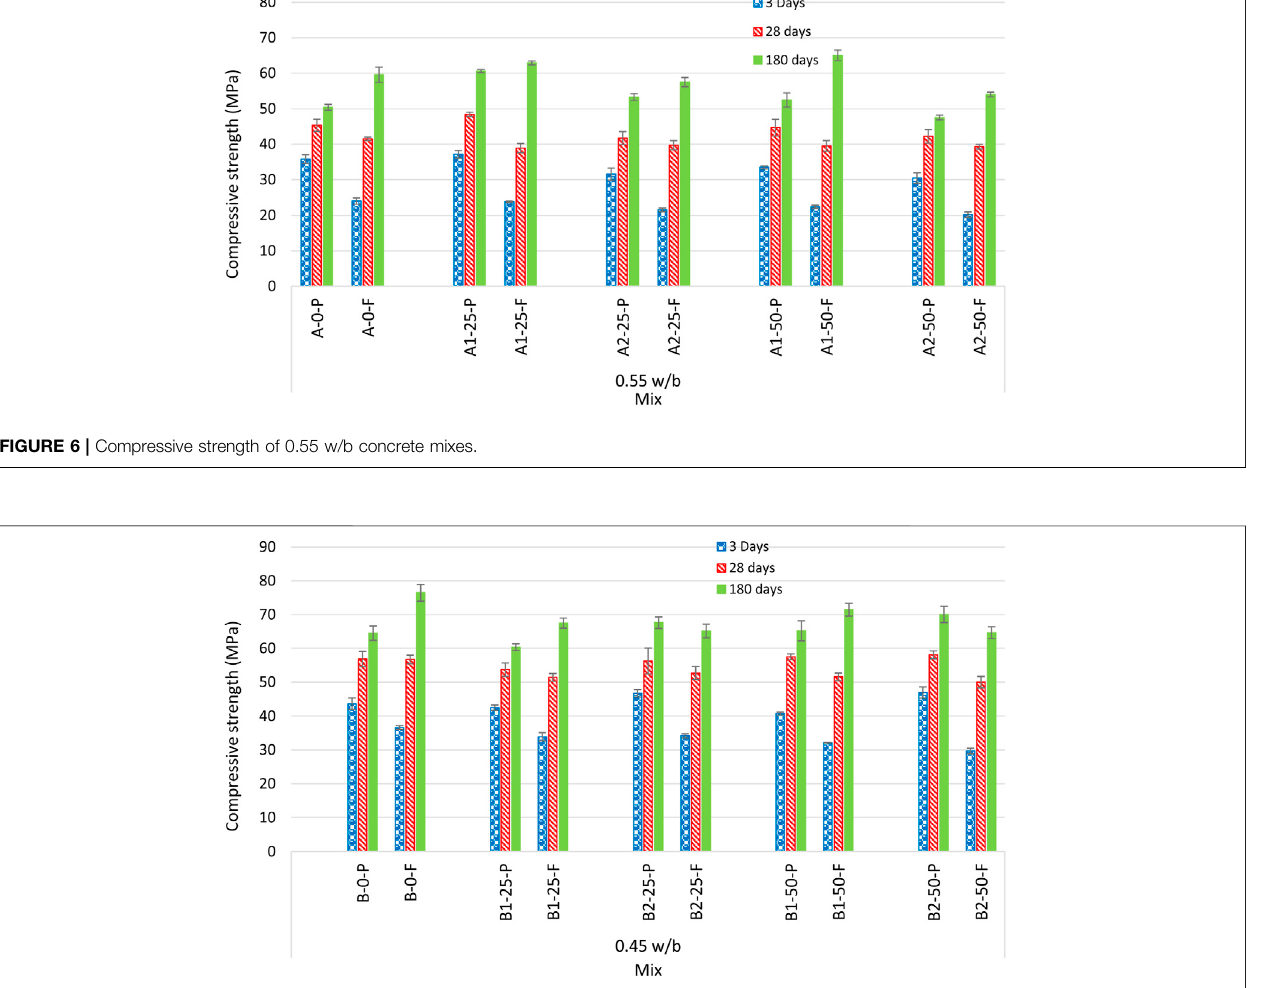
FIGURE 7 | Compressive strength of 0.45 w/b concrete